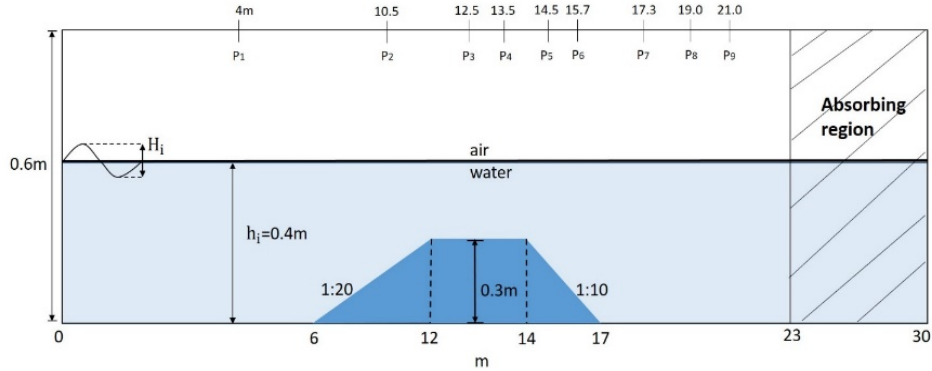
Figure5. Figure 5. Sketch of the computational domain for the linear waves passing over the trapezoid breakwater.